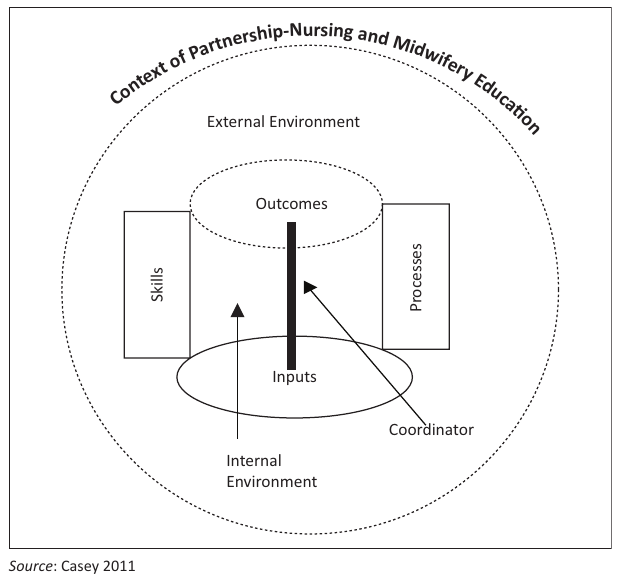
FIGURE 1: A new model for nursing and midwifery